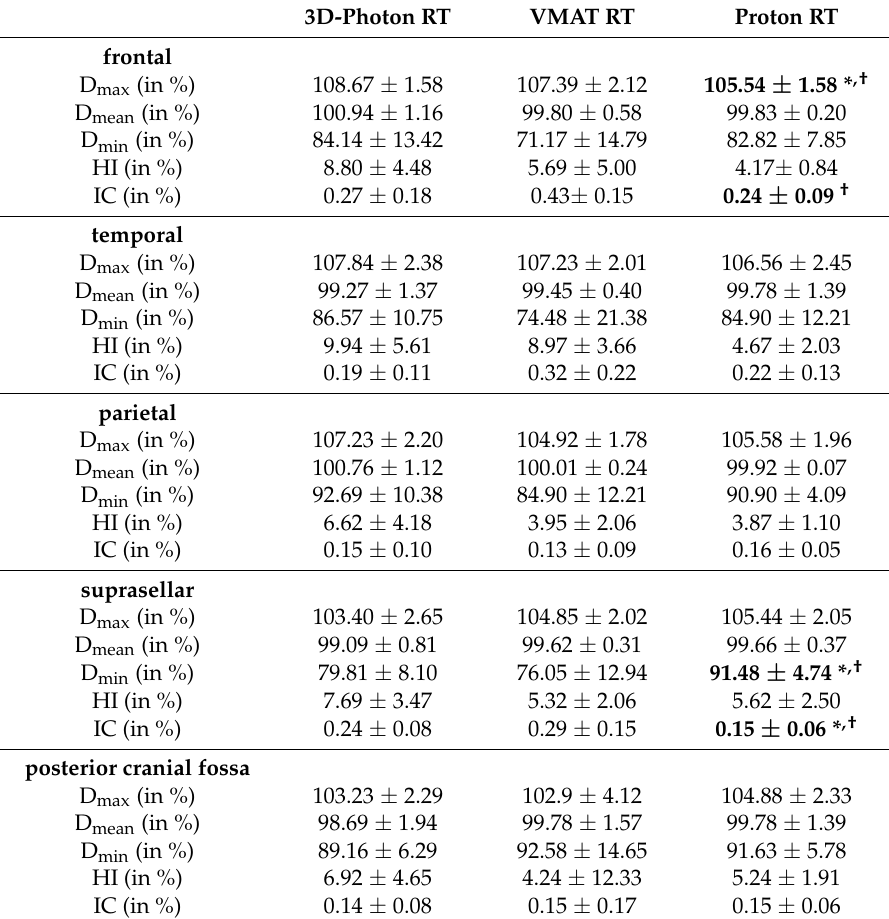
Table 7. Comparison of target volume